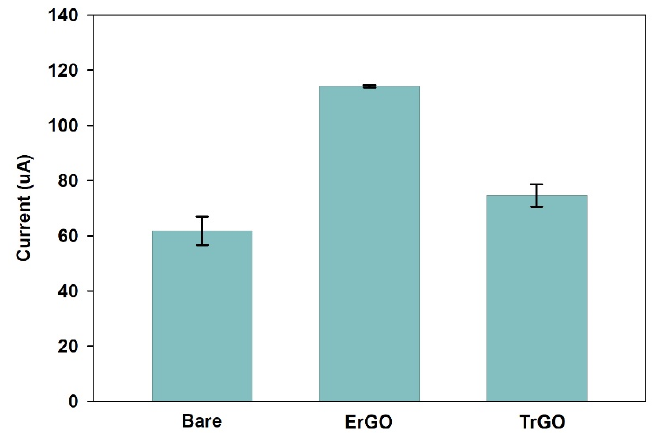
Figure A4. The anodic peak currents (I pa ) of 10 successive cycles of CV voltammograms of a bare electrode and electrodes modified with ErGO and TrGO.